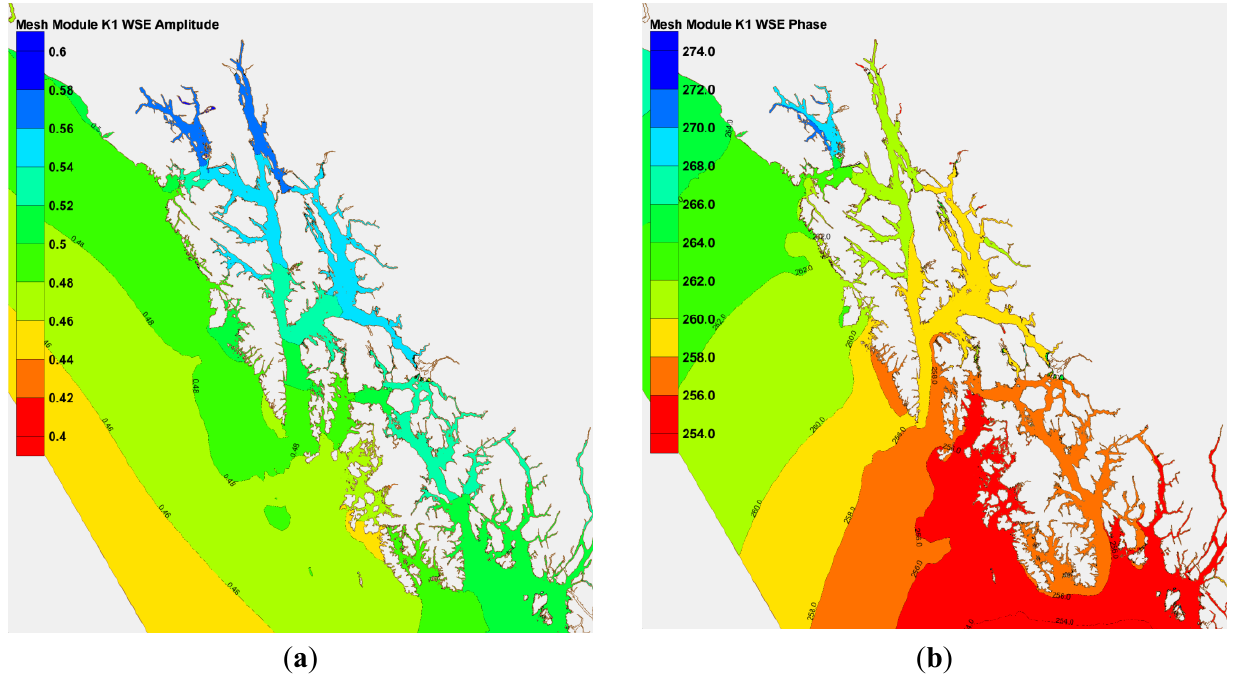
Figure 3. K tide ( a ) co-amplitude lines (meters); and ( b ) co-phase lines (degrees) in 1 SE Alaska.